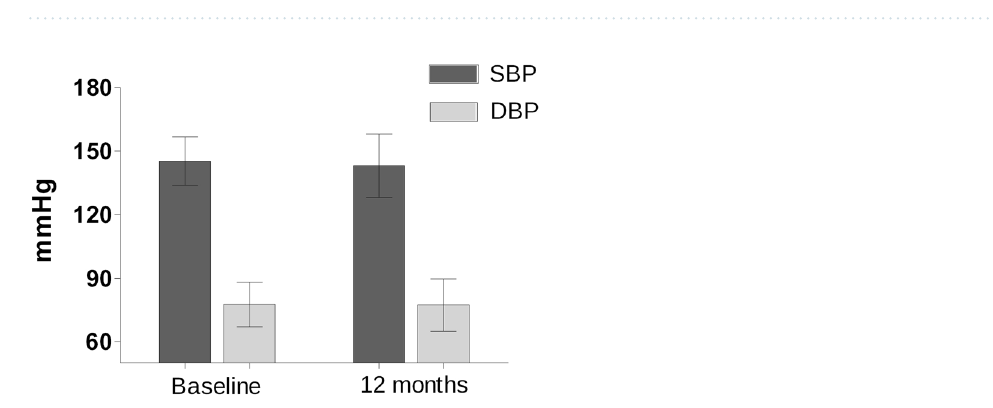
Figure 3. Impact of diabetes mellitus, baseline 24 h mean systolic blood pressure (SBP) and baseline 24 h mean diastolic blood pressure (DBP) on the response to renal denervation assessed with binary logistic regression analysis. X-axis represents odds ratio with logarithmic (log10) scale; * statistically significant with p = 0.007; # statistically significant with p = 0.045. Variables entered in multivariate analysis: baseline office SBP and DBP, baseline mean 24 h-SBP and mean 24 h-DBP, diabetes, isolated systolic hypertension, baseline heart rate, age, sex, body-mass-index, estimated glomerular filtration rate.